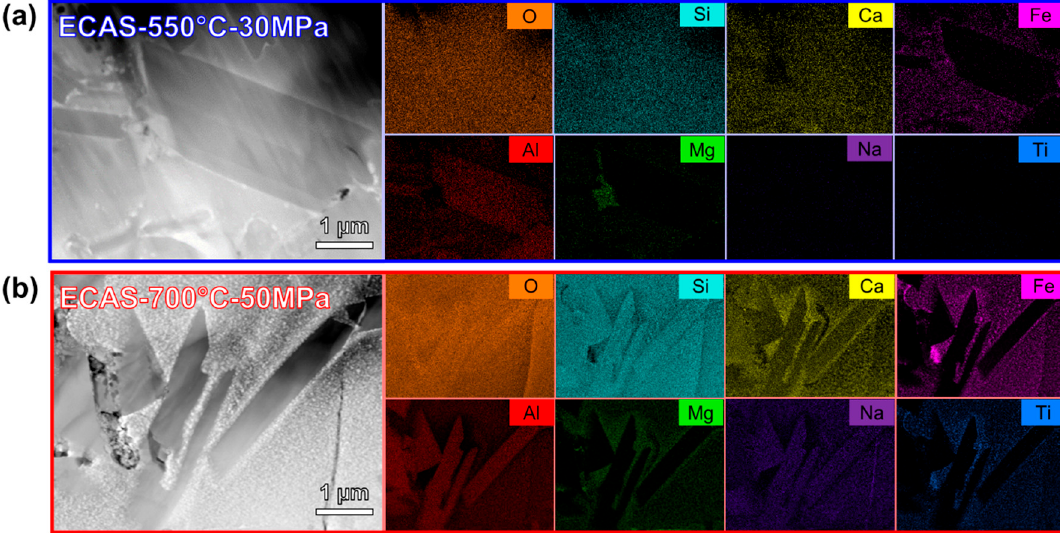
Figure 5. Scanning transmission electron microscopy (STEM) high-angle annular dark field (HAADF) images of ( a ) ECAS-550 °C-30 MPa and ( b ) ECAS-700 °C-50 MPa with the elemental mappings of elongated grains observed in the microstructure.